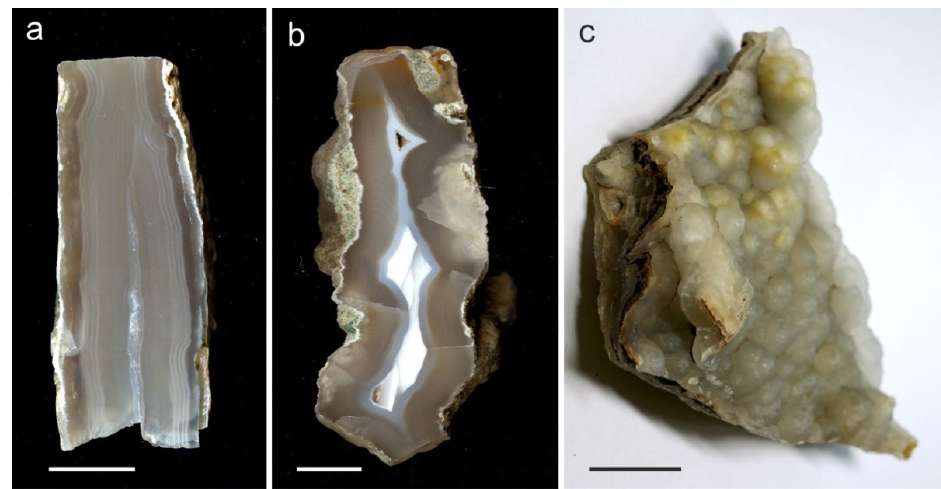
Figure 4. Selected samples of the investigated agate/chalcedony material from El Picado/Los Indios, Cuba representing three main types: ( a ) finely banded, vein-like agate (sample ACu1); ( b ) agate with a white center (ACu2); ( c ) botryoidal chalcedony (ACu3); the scale bar is 2 cm.